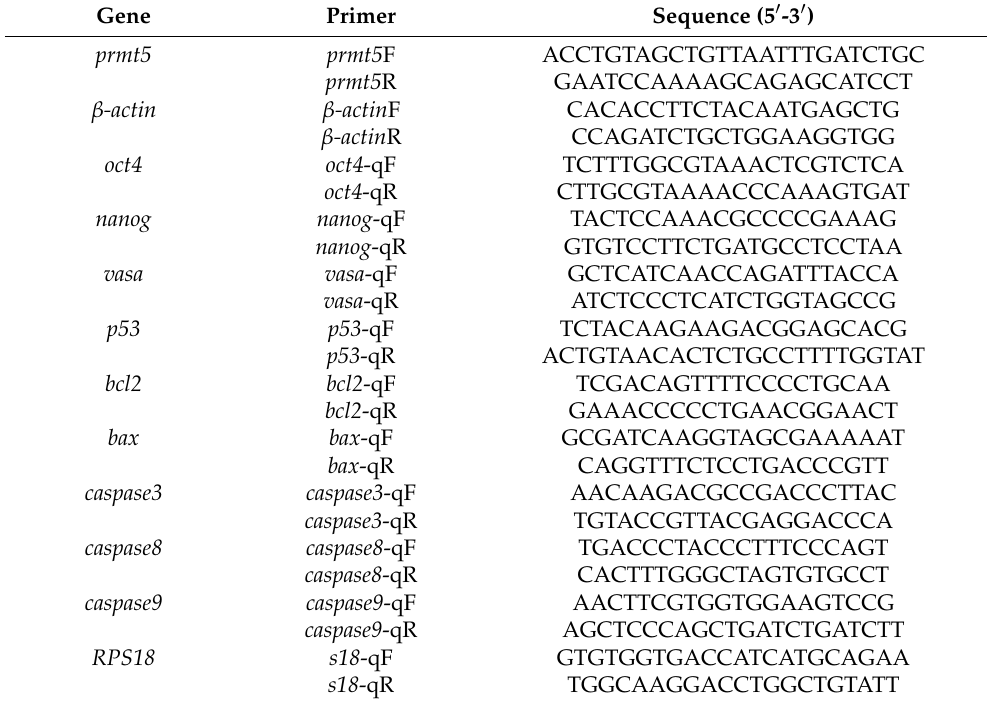
Table 1. The primers used in the